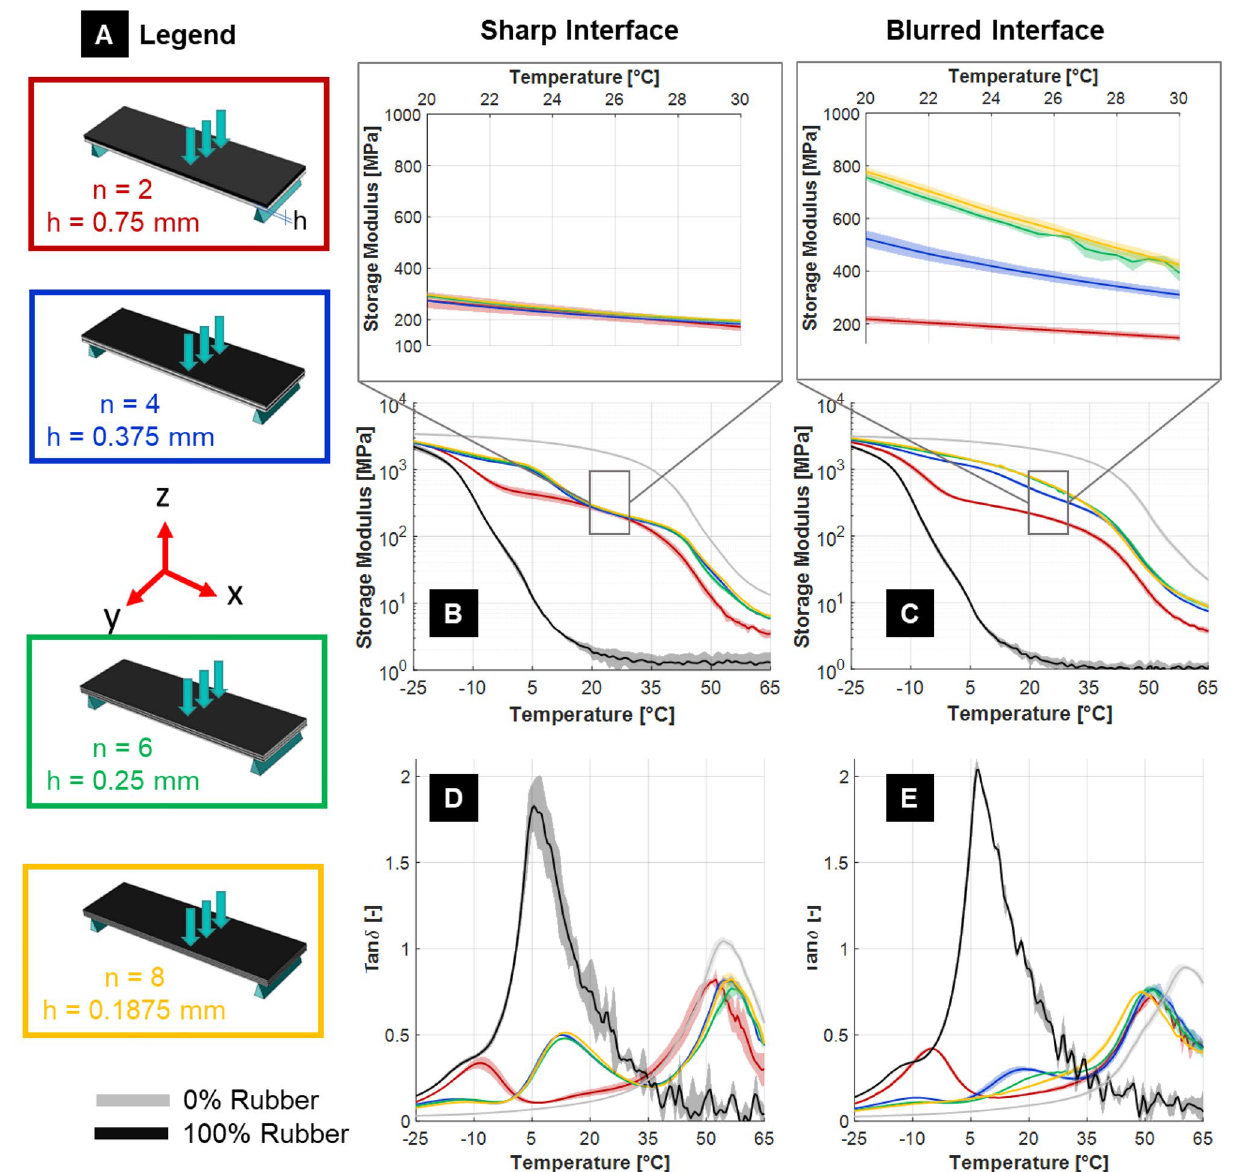
Reference curves for pure materials (black TB + and light grey VW +) are also